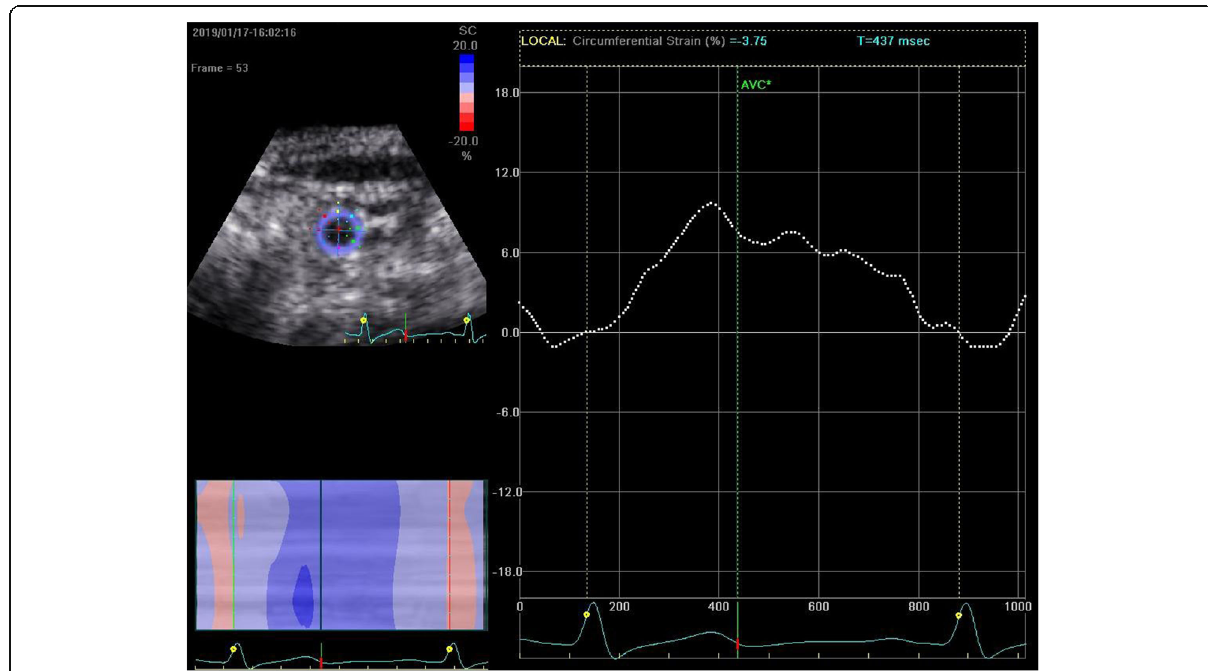
Fig. 3 Measurement of CS of a healthy individual by 2D-STE. The image was obtained from the short-axis view of the right common carotid artery